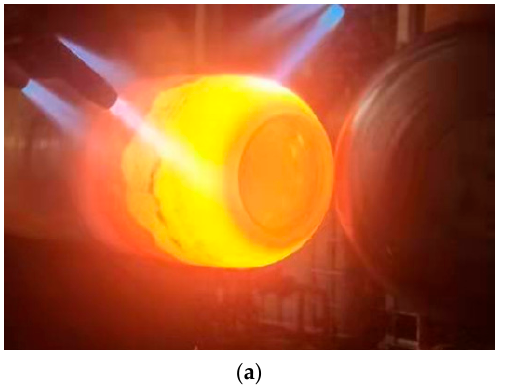
( d ) Figure 8. Spinning forming experiment process. ( a ) Spinning process 1. ( b ) Spinning process 2. ( c ) Spinning process 3. ( d ) Spinning process 4. 4. Hydrogen Embrittlement Test after Spinning 4.1. Test Principle A mounted disc-shaped test piece was subjected to an increasing gas pressure at a constant rate to facilitate bursting or cracking. The hydrogen embrittlement effect was demonstrated by comparing the hydrogen rupture pressure PH2 with the helium rup- ture pressures PHe, where helium was chosen as a reference gas. Specifically, the ratio PHe/PH2 was determined. The lower this ratio, the better the behavior of steel in the presence of hydrogen. This ratio was dependent on the pressure rise rate, which re- mained constant during the entire test. The test results were interpreted considering that the material embrittlement index was equal to the maximum value of the ratio PHe/PH2 and that the material was suitable for compressed hydrogen cylinders if the index was less than or equal to 2. 4.2. Test Conditions and Procedure The tests were conducted with high-purity hydrogen (>99.9995%) and helium (H20 < 3 μ L/L) for different pressure rise rates ranging between 0.1 bar/min to 1000 bar/min. The minimum value of the rupture pressure was determined when the later pressure rates were employed. This minimum value was used to run the remaining tests. Generally, six helium tests and nine hydrogen tests (i.e., 15 tests in total) are considered to be sufficient for a thorough material evaluation.